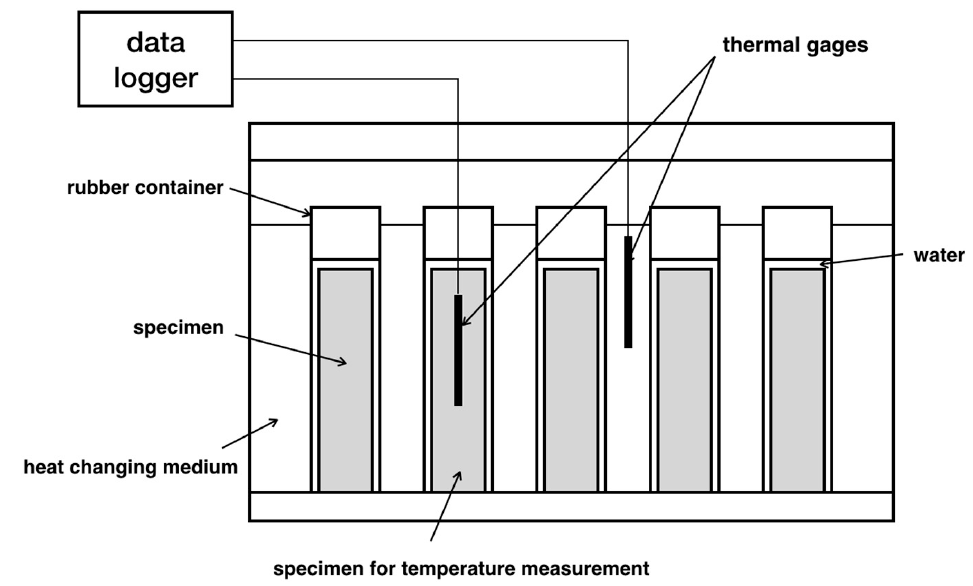
Figure 1. Rapid freezing–thawing testing apparatus according to ASTM C666